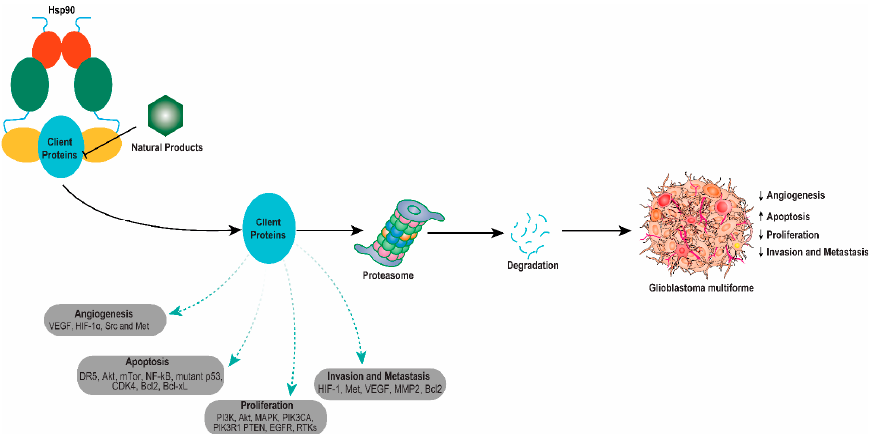
Figure 2. Molecular mechanism of Hsp90 inhibition by natural products in GBM. Hsp90 client proteins play essential roles in GBM progression and maintenance. Targeting several signal transduction pathways that support GBM growth and survival can be facilitated when Hsp90 is inhibited, stimulating the degradation of Hsp90 client proteins by ubiquitin-proteasome systems.